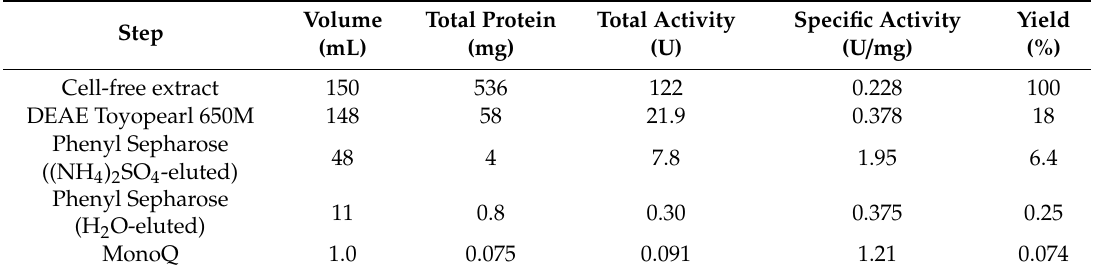
Table 1. Purification of cis -naphthalene dihydrodiol dehydrogenase (NahB).